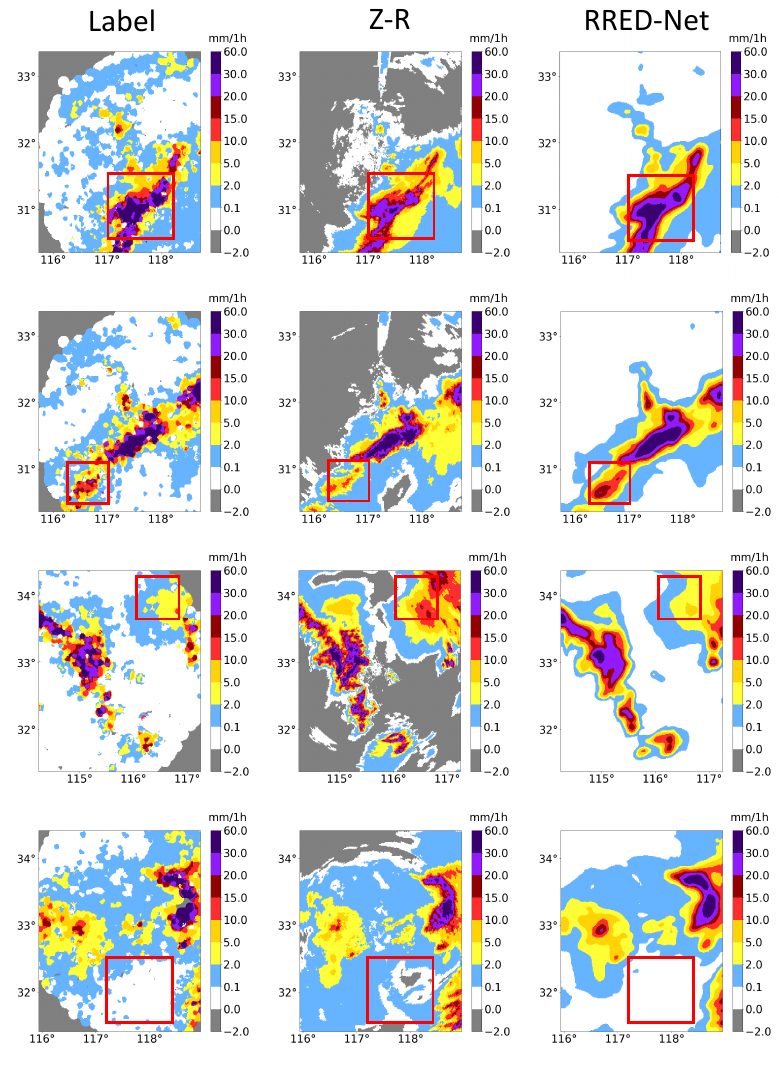
Figure 9. Visualization examples. An hour precipitation images measured and predicted during 21:41–22:40 BT (Beijing Time), 5 July 2018; 19:47–20:46 BT, 5 July 2018; 19:43–20:42 BT, 26 July 2018; 11:08–12:07 BT, 5 July 2018, from up to down, respectively. Label, the Z − R relationship from left to right and the predictions of RRED-Net, respectively. The red box highlights parts of the images.